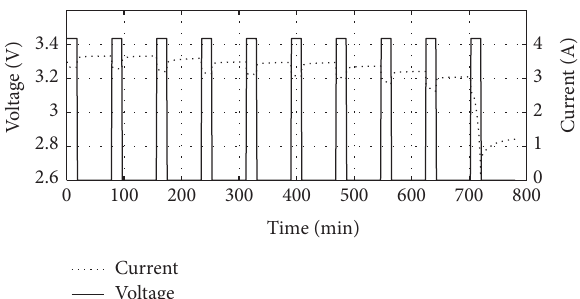
Figure 3: Terminal current/voltage curves by constant-current dis- charge pulse.